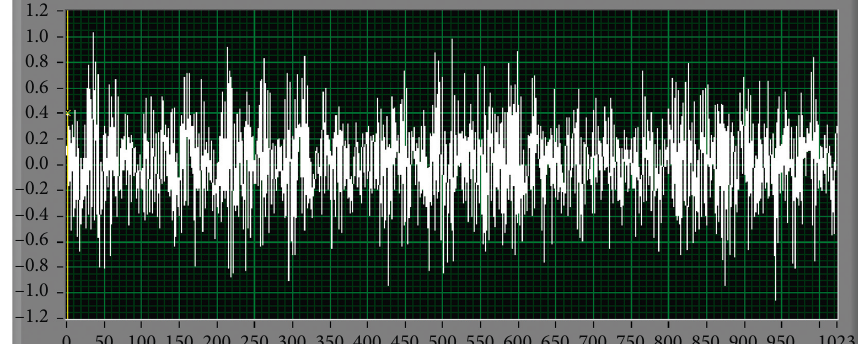
Figure 3: Vibration image in the normal running state.